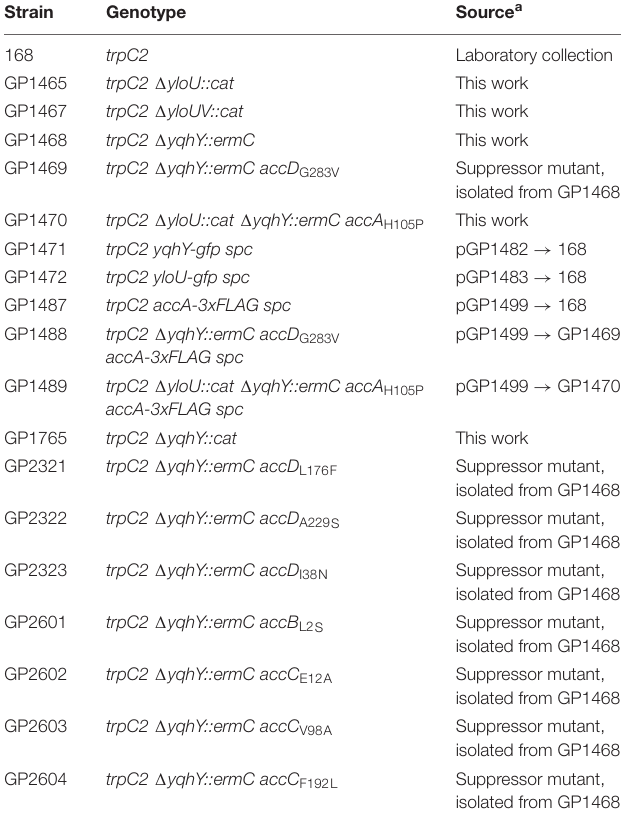
TABLE 1 | Bacillus subtilis strains used in this study.